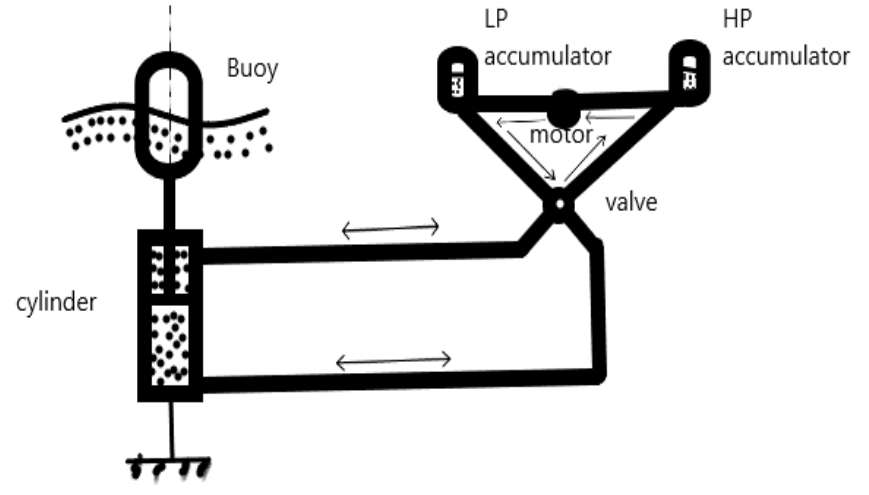
Figure 8. The OBC working principle.